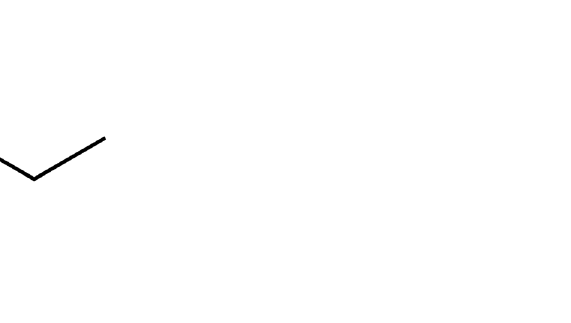
Figure 1. Structures of caffeoylquinic acids (CQAs).